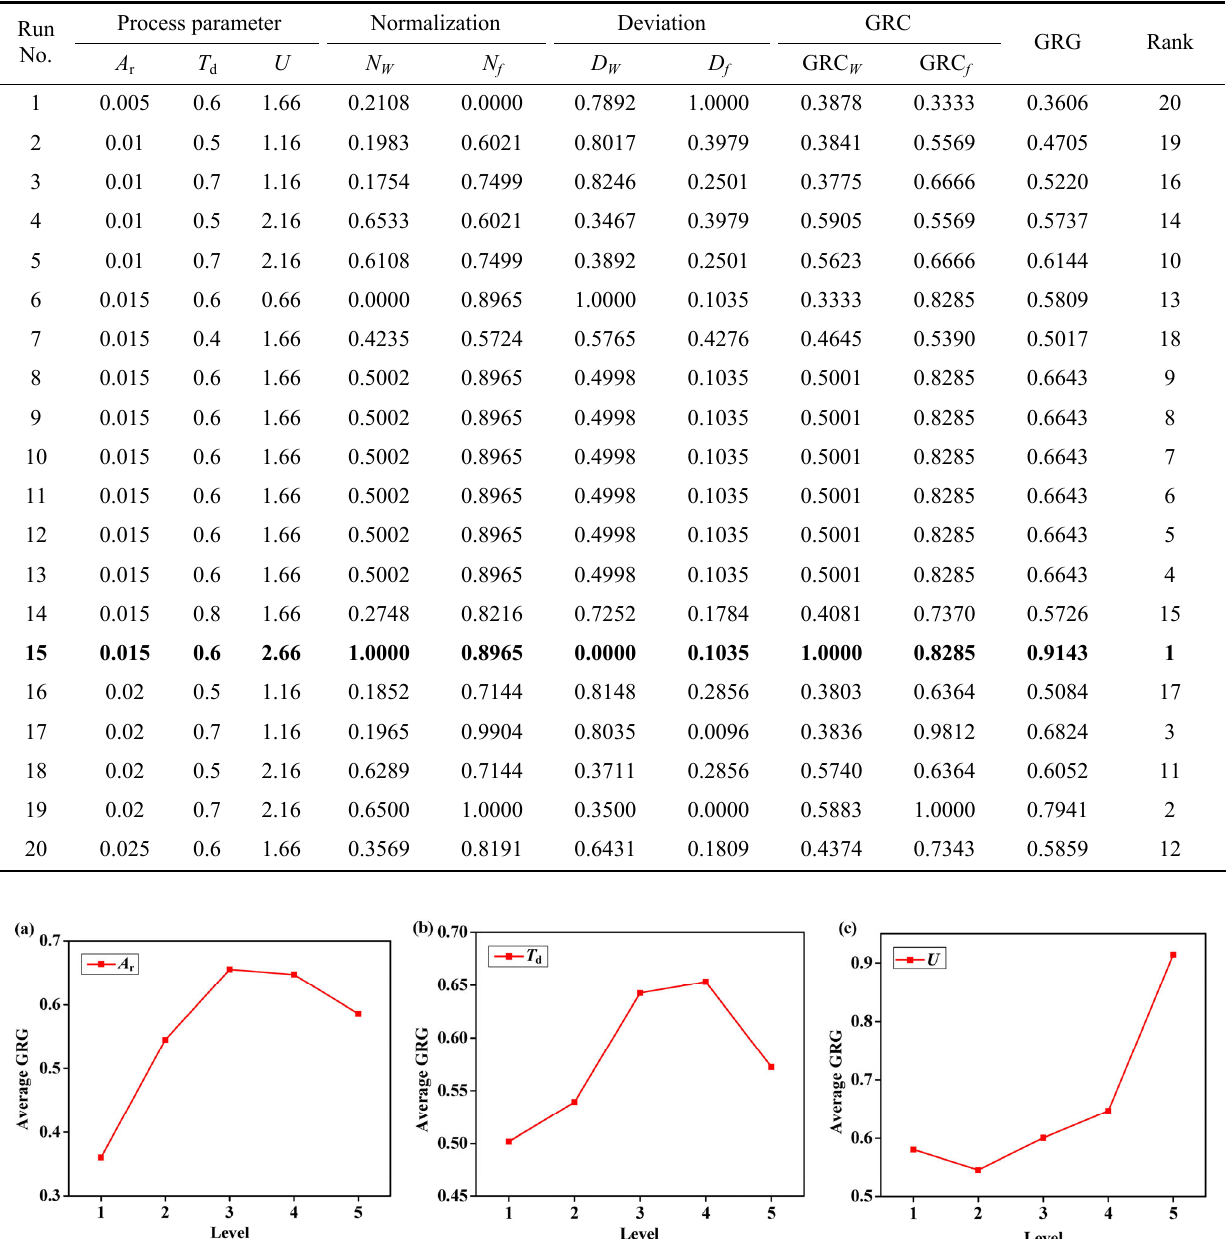
Table 4 GRA of flat bottom profile.